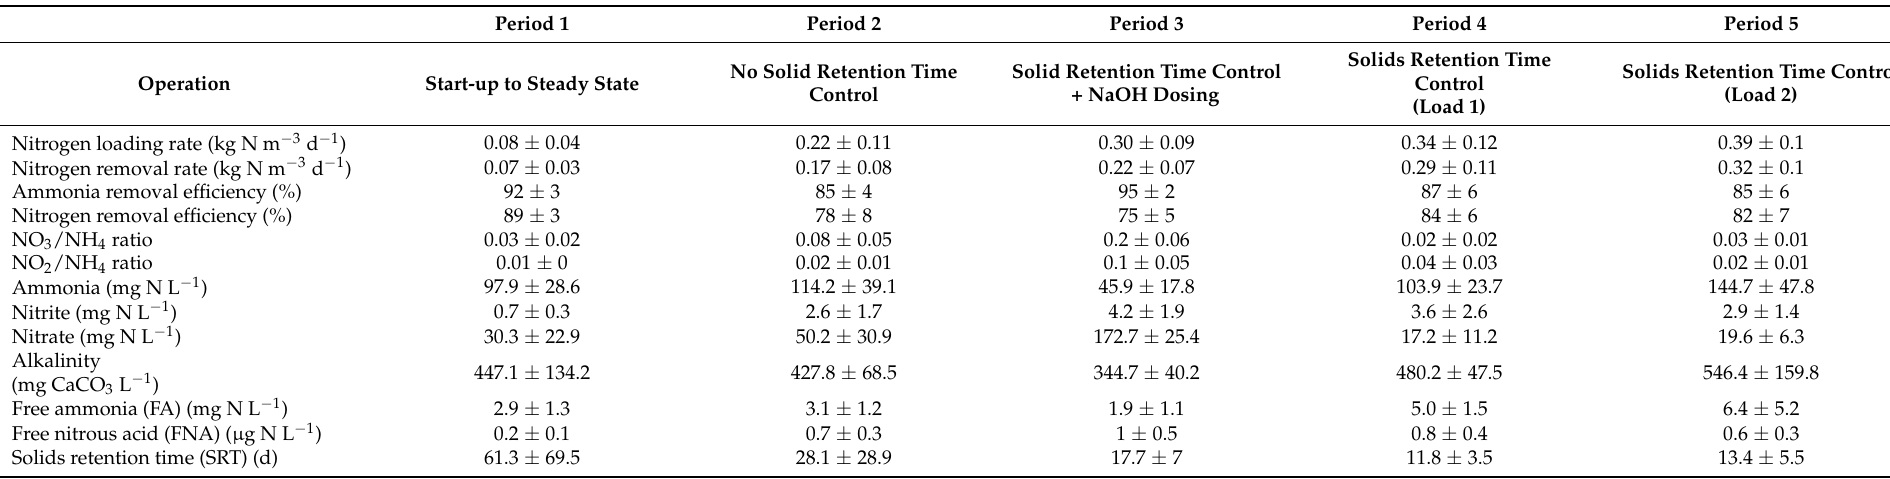
Table 2. Effluent characteristics and performance of the suspended sludge continuous stirred tank reactor for Period 1 to Period